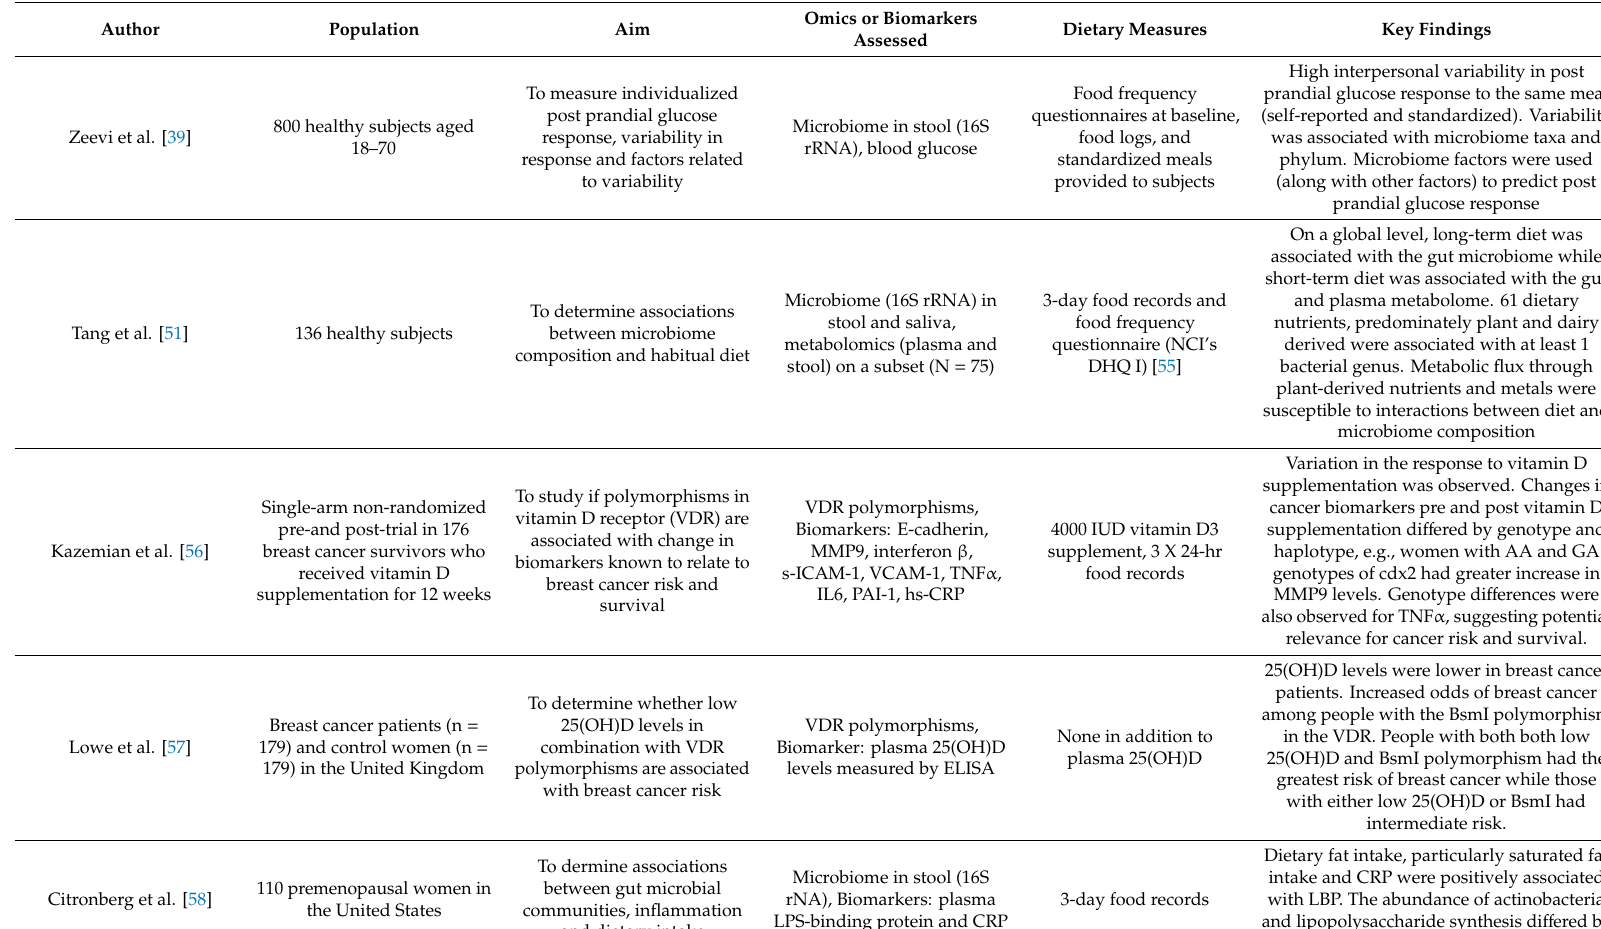
Table 1. Key studies using multi-omics or omics in combination with a biomarker to study diet–cancer